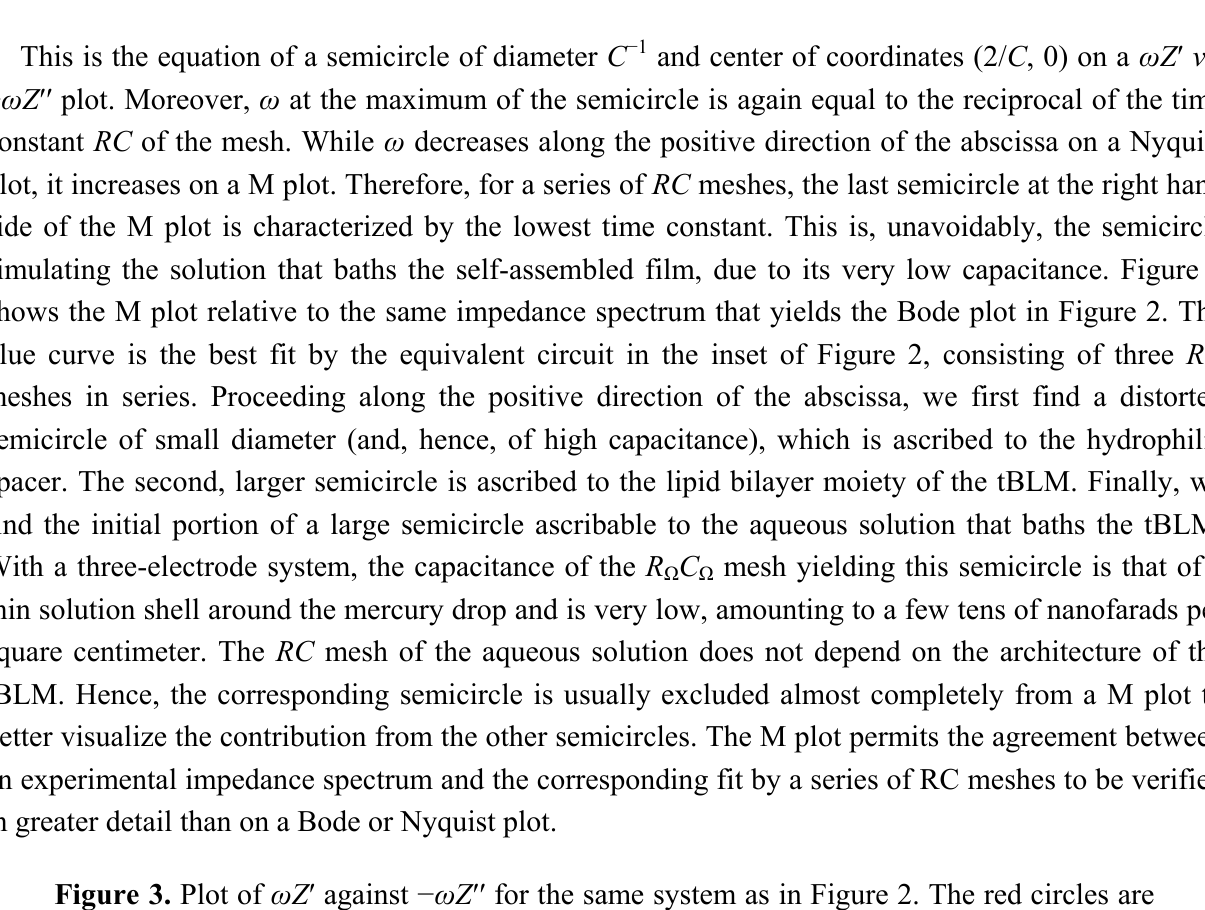
Figure 3. Plot of ω Z ′ against − ω Z ′′ for the same system as in Figure 2. The red circles are experimental values and the blue curve is the best fit. The inset shows an enlargement of the distorted semicircle of smallest diameter (and, hence, highest capacitance) ascribed to the hydrophilic